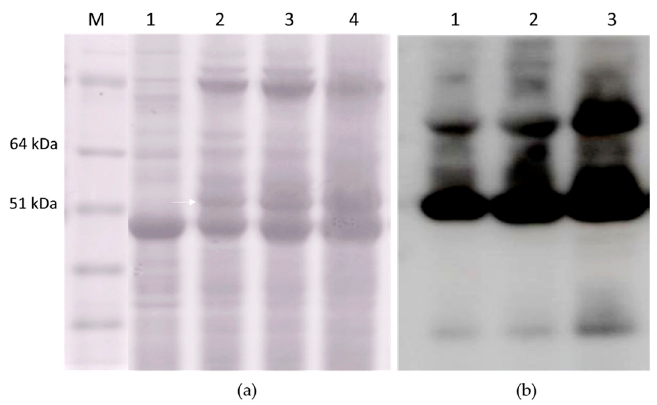
Figure 9. ( a ) SDS-PAGE of 3 mg FW; M. Molecular weight marker (kD); 1. Plant inoculated with empty pEAQ- HT ; 2. TSP extracted at two dpi; 3. TSP extracted at four dpi; 4. TSP extracted at six dpi; and ( b ) Western blot with anti-HEV ORF2 mAb of TSP extracted from M2 HEV 110–610 at two dpi (lane 1), at four dpi (lane 2), and at six dpi (lane 3).